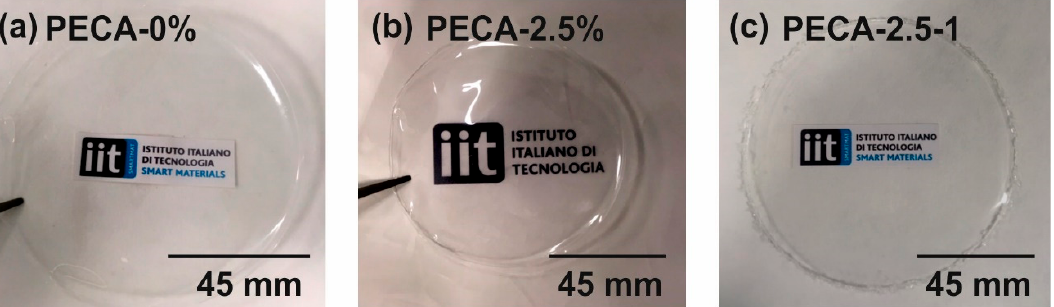
Figure 1. Photographs of ( a ) transparent pristine poly(ethyl cyanoacrylate) (PECA), ( b ) PECA blended with 2.5 wt.% of poly(propylene carbonate) (PPC) and ( c ) PECA blended with 2.5 wt.% of PPC with 1.0 wt.% of caffeic acid. Table 1. Composition of the dry films studied in this work. CA stands for caffeic acid, PPC for poly(propylene carbonate) and PECA for poly(ethyl cyanoacrylate). Concentration of PPC Concentration of CA Polymer Film (wt.%) (wt.%)